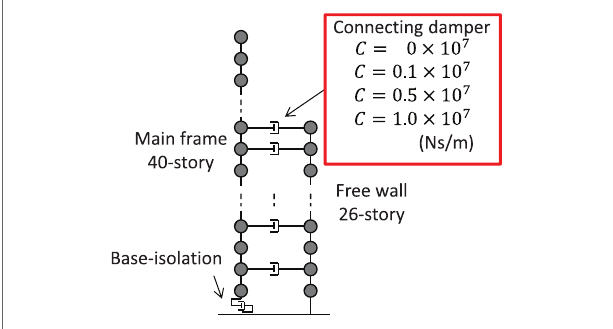
FIGURE 5 | Base-isolation building-connection hybrid controlled building structure. TABLE 1 | Structural parameters.